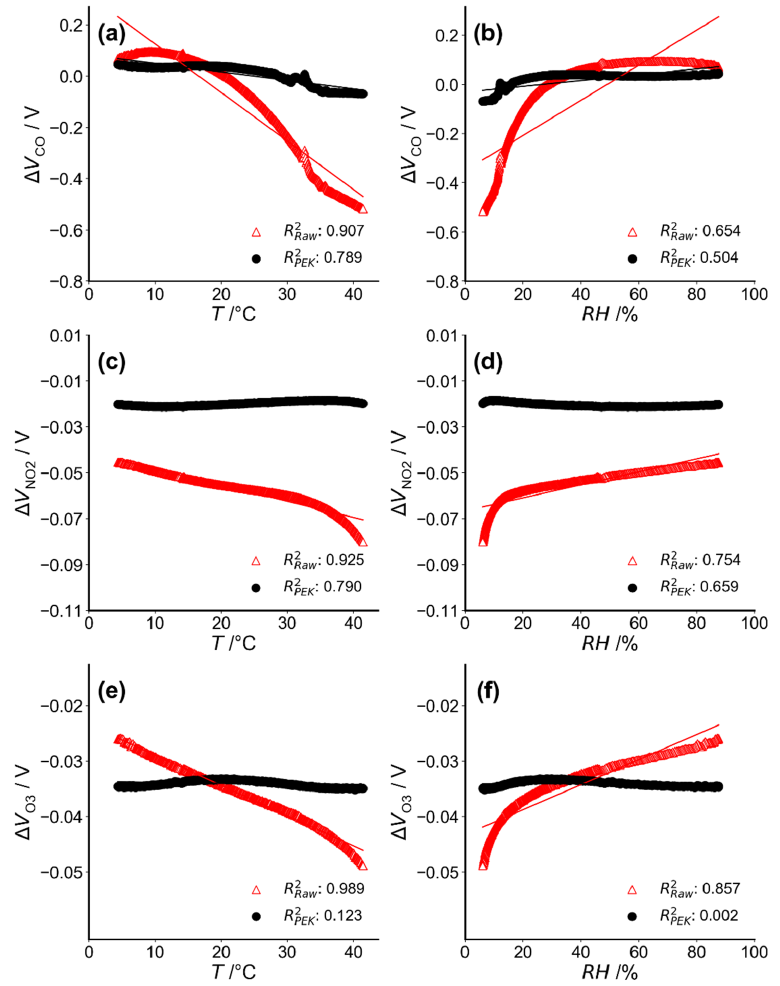
Figure 3. Raw sensor (red lines) and corrected output (black lines) responses to zero air against changing temperature ( a , c , e ) and humidity ( b , d , f ). Note: Corrected outputs are corrected using the dynamic baseline method.